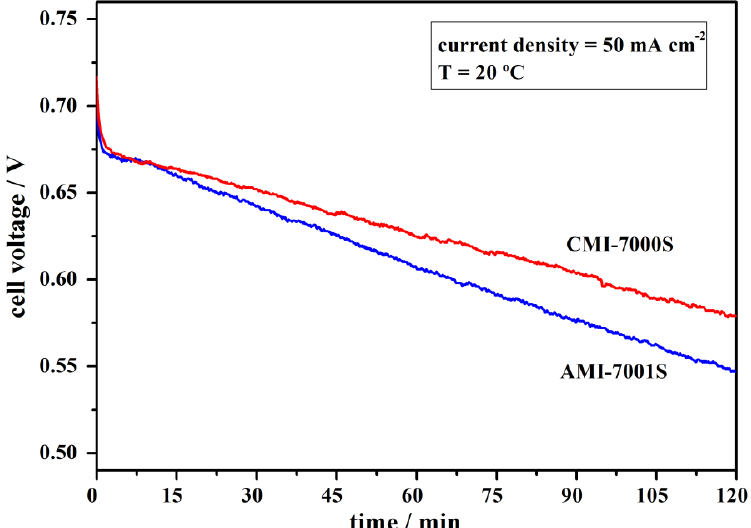
Figure 5. Performance stability of DBPFCs employing AMI-7001S and CMI-7000S membrane separators recorded at the operating current density of 50 mA·cm − 2